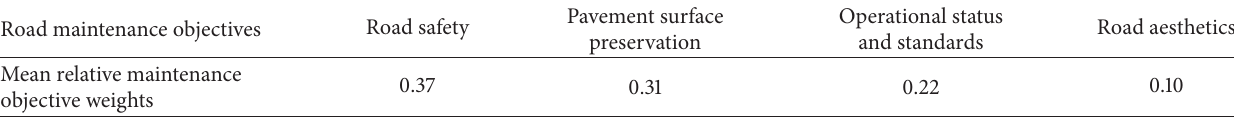
Table 10: Average maintenance objectives weighting vector ( 𝑊 ) for the case